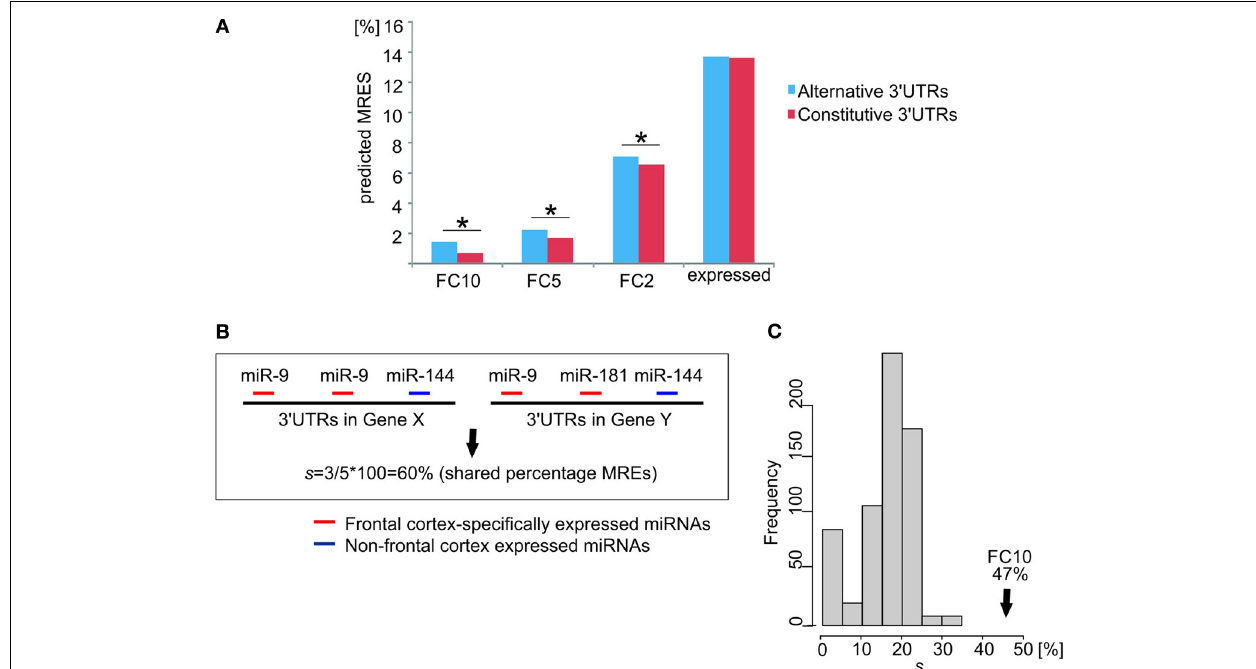
FIGURE 4 | Frontal cortex specifically expressed miRNAs targeting 3 (cid:2) UTR extensions strengthen the cross-talk between ion channel/transporter genes. (A) Differences in the percentage of predicted MREs for miRNA families expressed in human adult frontal cortex (y-axis for different levels of relative expression: FC10, FC5, FC2, and expressed) between constitutive (red) and alternative (blue) 3 (cid:2) UTRs of ion channel/transporter genes . ∗ indicates a significant difference ( p < 0 . 05). (B) Calculation of the percentage (%) of shared MREs, s, between two ion channel/transporter genes. Gene X and Gene Y have two and one predicted MREs for a frontal